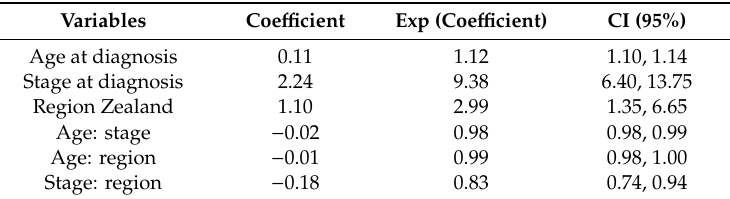
Table 6. Results from a Cox proportional hazard model, comparing hazards from Central Denmark and Zealand,